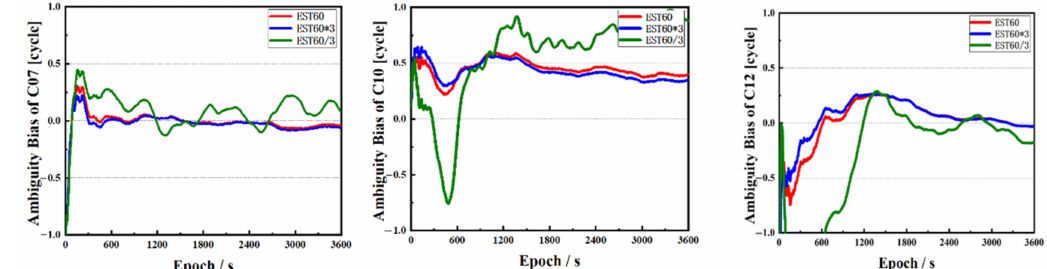
Figure 10. The float ambiguity estimated of C07, C10 and C12 for the solution EST60, EST60 × 3 and EST60 ÷